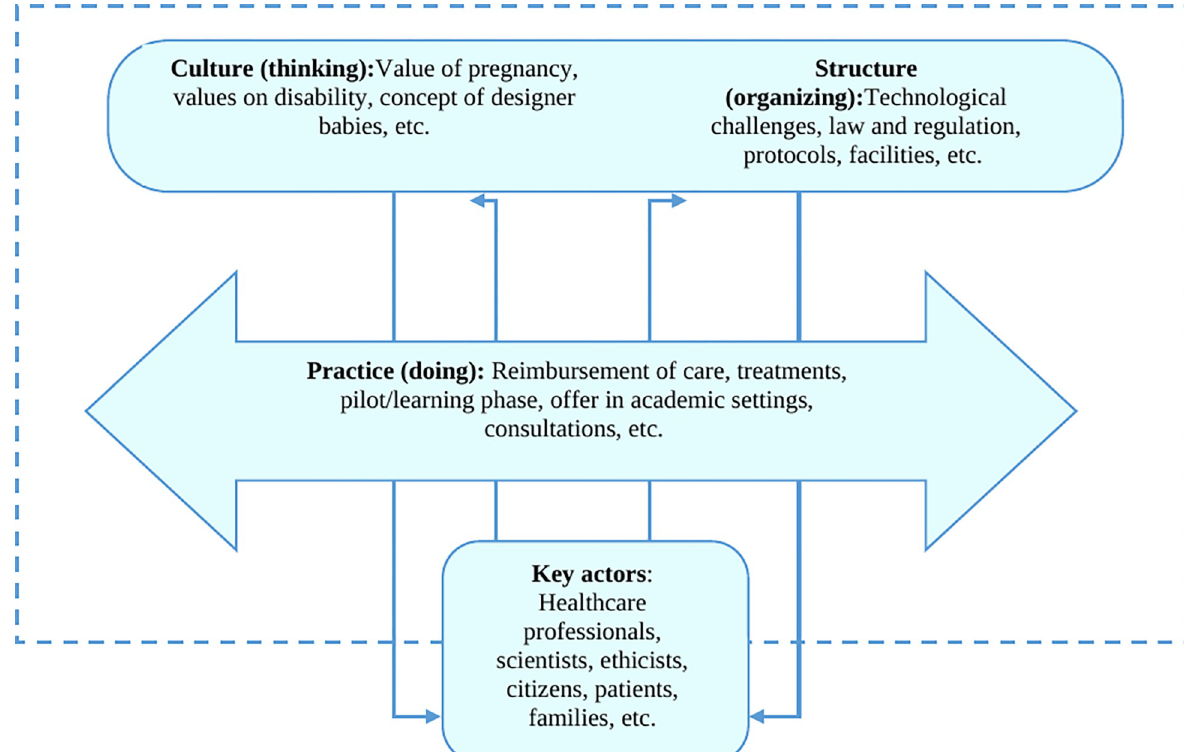
Fig 1. The existing system of reproductive medicine: Operationalization of the constellation concept into structure, culture and practice, adapted from Rigter [25] and van Raak [23].